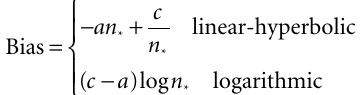
FIGURE 3 | Two models for numerosity bisection. (A) In both models, positive and negative neuronal responses from LIP neurons enter as evidence for “large” and “small” cue classifi cations, respectively. In addition, a bias input represents an additional propensity to choose one response over the other. In the fi gure, black lines represent excitation, red lines inhibition. The bias input augments the probability of perceiving the cue as “large,” though in other cases it might favor a “small” outcome. Competition between the two tuning curves computes an effective difference in fi ring rates, which is passed on to a softmax choice model that apportions choices based on this difference (see Materials and Methods). (B) A family of choice curves generated by systematically decreasing the bias input in the model in (A) . As bias decreases, the point of subjective equality (PSE) shifts